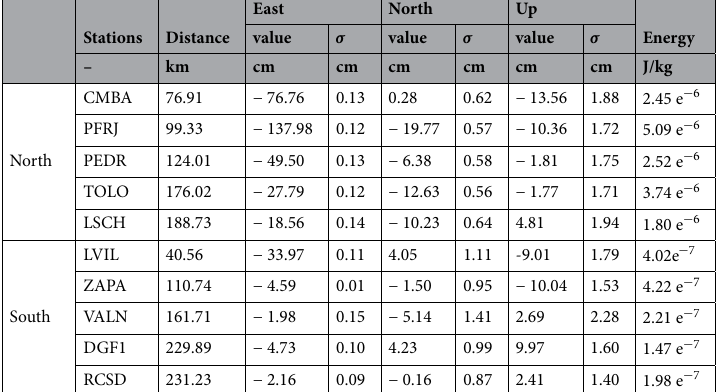
Table 1. Overall coseismic displacements and their standard deviations for the GPS stations within 300 km from the epicenter. The last column shows the value for the energy connected to the Up component of the earthquake ground